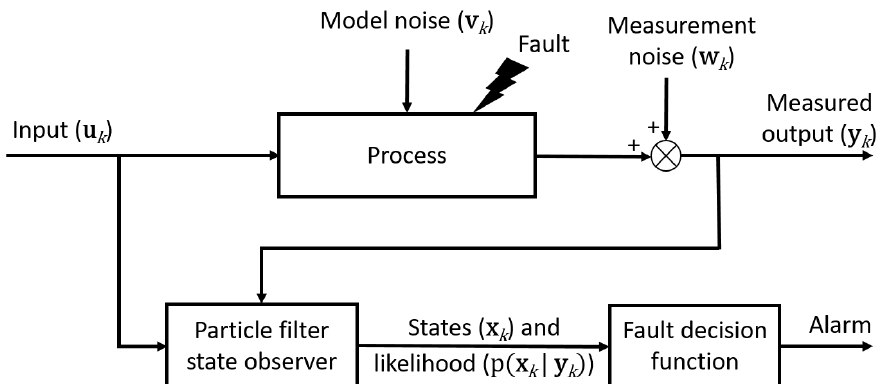
Figure 1. Particle filter state observer-based fault detection scheme of a process. The particle filter state observer computes the unmeasured states in light of the measured sensor data and the inputs of the process. According to the fault decision function, the faults can be detected and alarms generated. Faults can be technological faults, parameter uncertainties or sensor